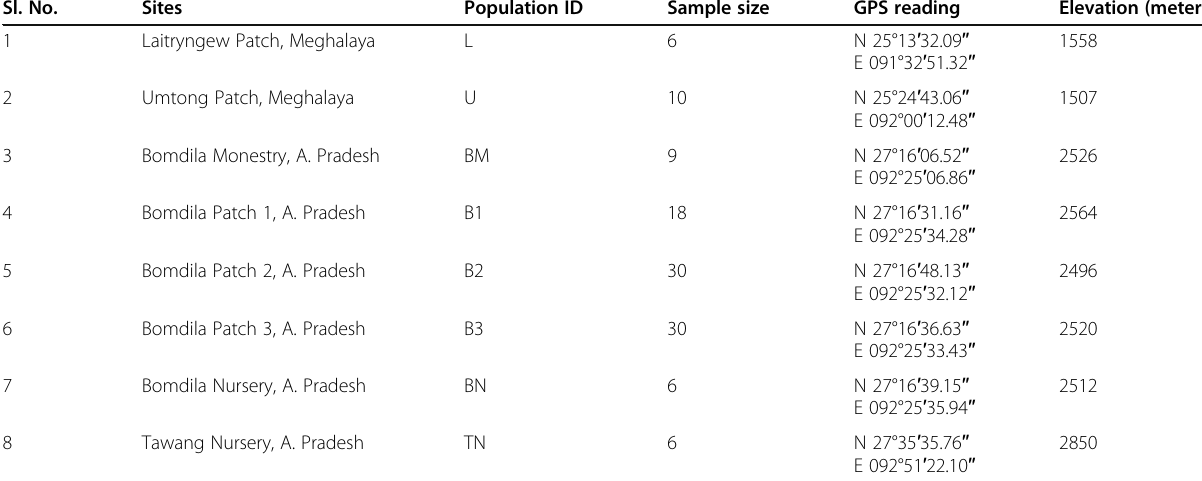
Table. 1 Collection sites of I . griffithii from different areas of Meghalaya and Arunachal Pradesh Sl. No.